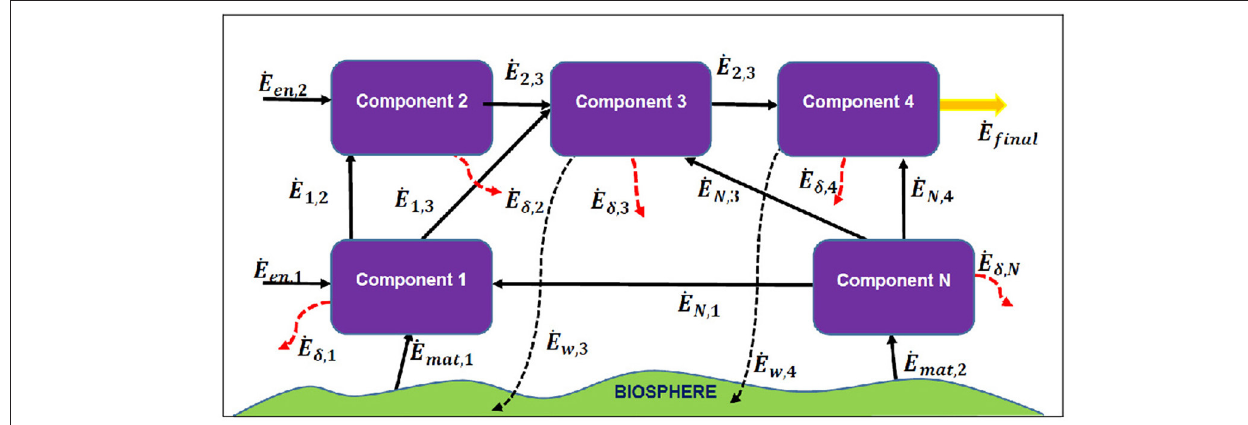
FIGURE 7 | The control volume for a Cumulative Exergy Consumption (CExC) analysis.